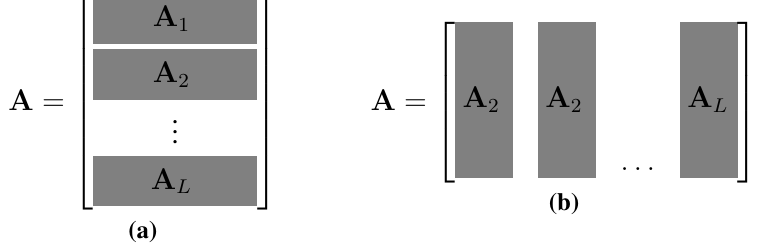
Figure 3. Matrix partitioning for the distributed basis